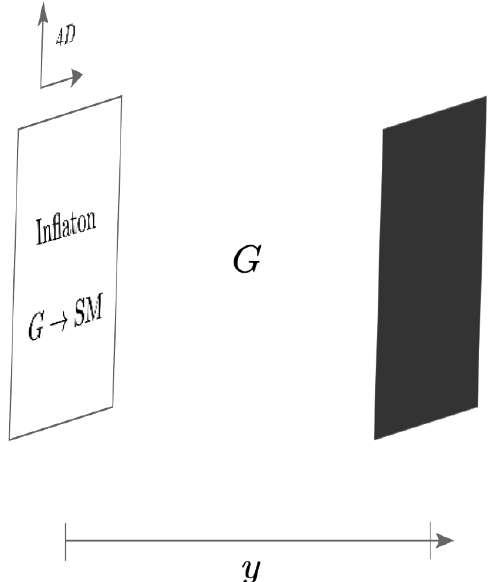
Figure 4 . Same set-up as in (cid:12)gure 2 except the right boundary is absent and a \black brane" horizon has formed due to the backreaction of the in(cid:13)ationary vacuum energy on the left boundary.